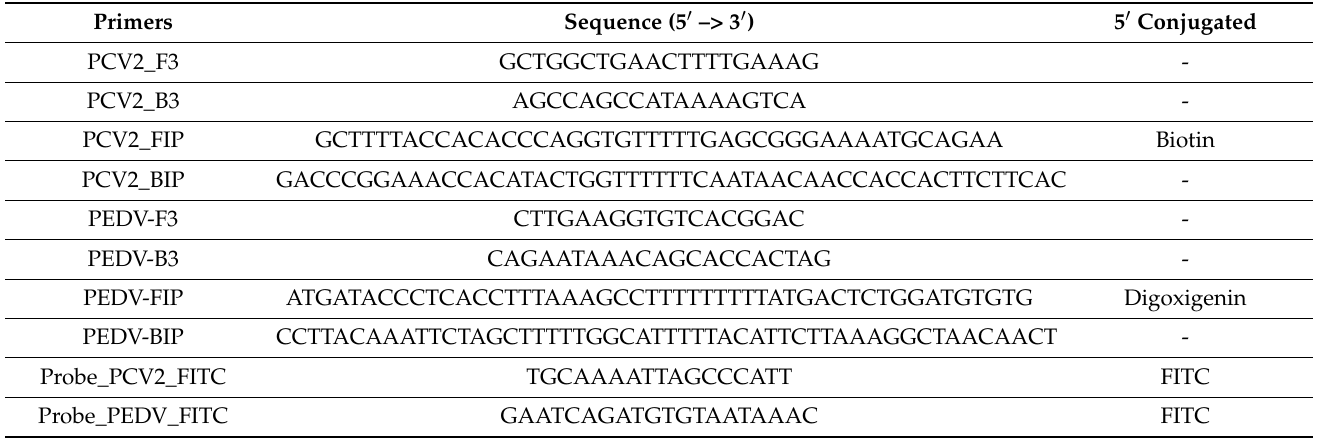
Table 1. Primers and probes used in this